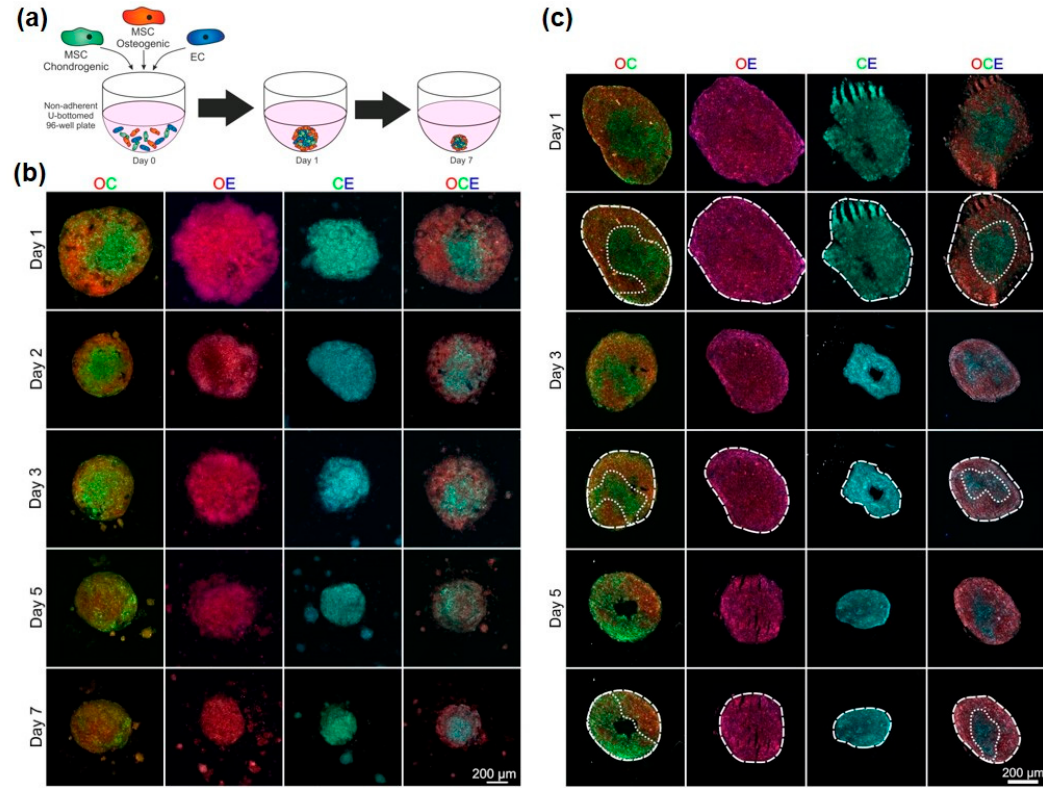
Figure 4. Organisation of ECs in pre-differentiated MSC spheroids. ( a ) Schematic showing technique for combining chondrogenic MSCs, osteogenic MSCs and ECs. MSCs were pre-differentiated for 7 days before being combined with ECs to form various mixed-cell spheroids. Osteogenic MSCs (O) were labelled red, chondrogenic MSCs (C) were labelled green and ECs (E) were labelled blue. ( b ) Images of whole spheroids in OC, OE, CE and OCE combinations. ( c ) Sections of OC, OE, CE and OCE spheroids with dotted line overlays added to distinguish colour separations.